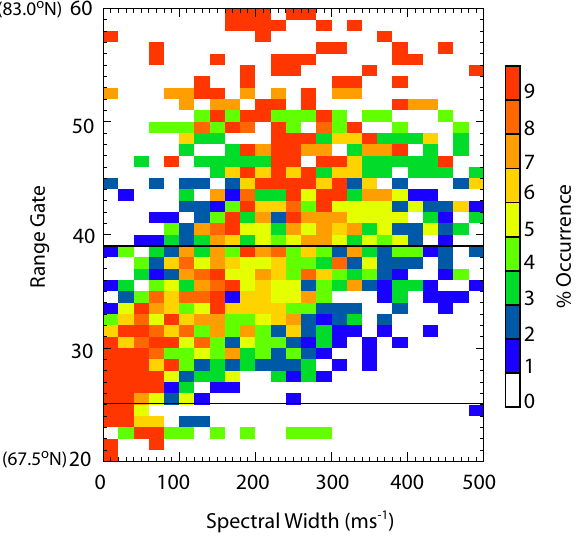
Fig. 4. A contour plot of spectral width distributions for beam 9, range gates 20 ( ∼ 67.5 ◦ N) through 60 ( ∼ 83.0 ◦ N) for the interval 01:30UT to 05:30UT. The colour scale indicates percentage occur- rence with the distributions normalised to the total number of obser- vations from each range gate. The very low spectral width values are not due to ground